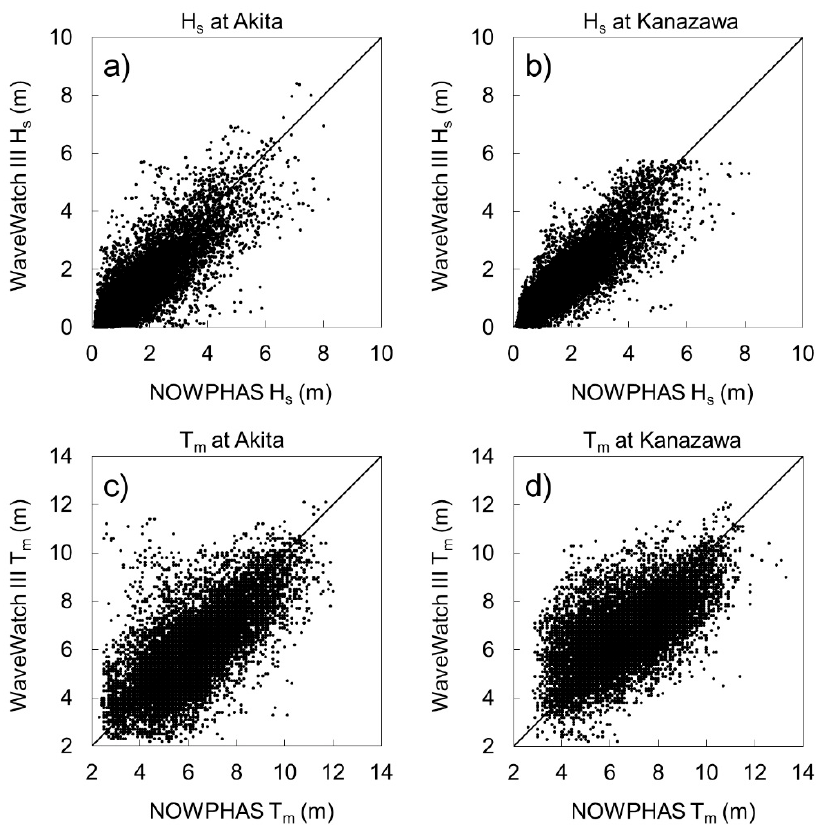
Figure 2. Significant wave height ( H s ) and mean wave period ( T m ) by NOWPHAS observation and WaveWatchIII (WW3) simulation. ( a ) H s at Akita, ( b ) H s at Kanazawa, ( c ) T m at Akita, and ( d ) T m at Kanazawa. Horizontal and vertical axes of each panel represent NOWPHAS and WW3, respectively.